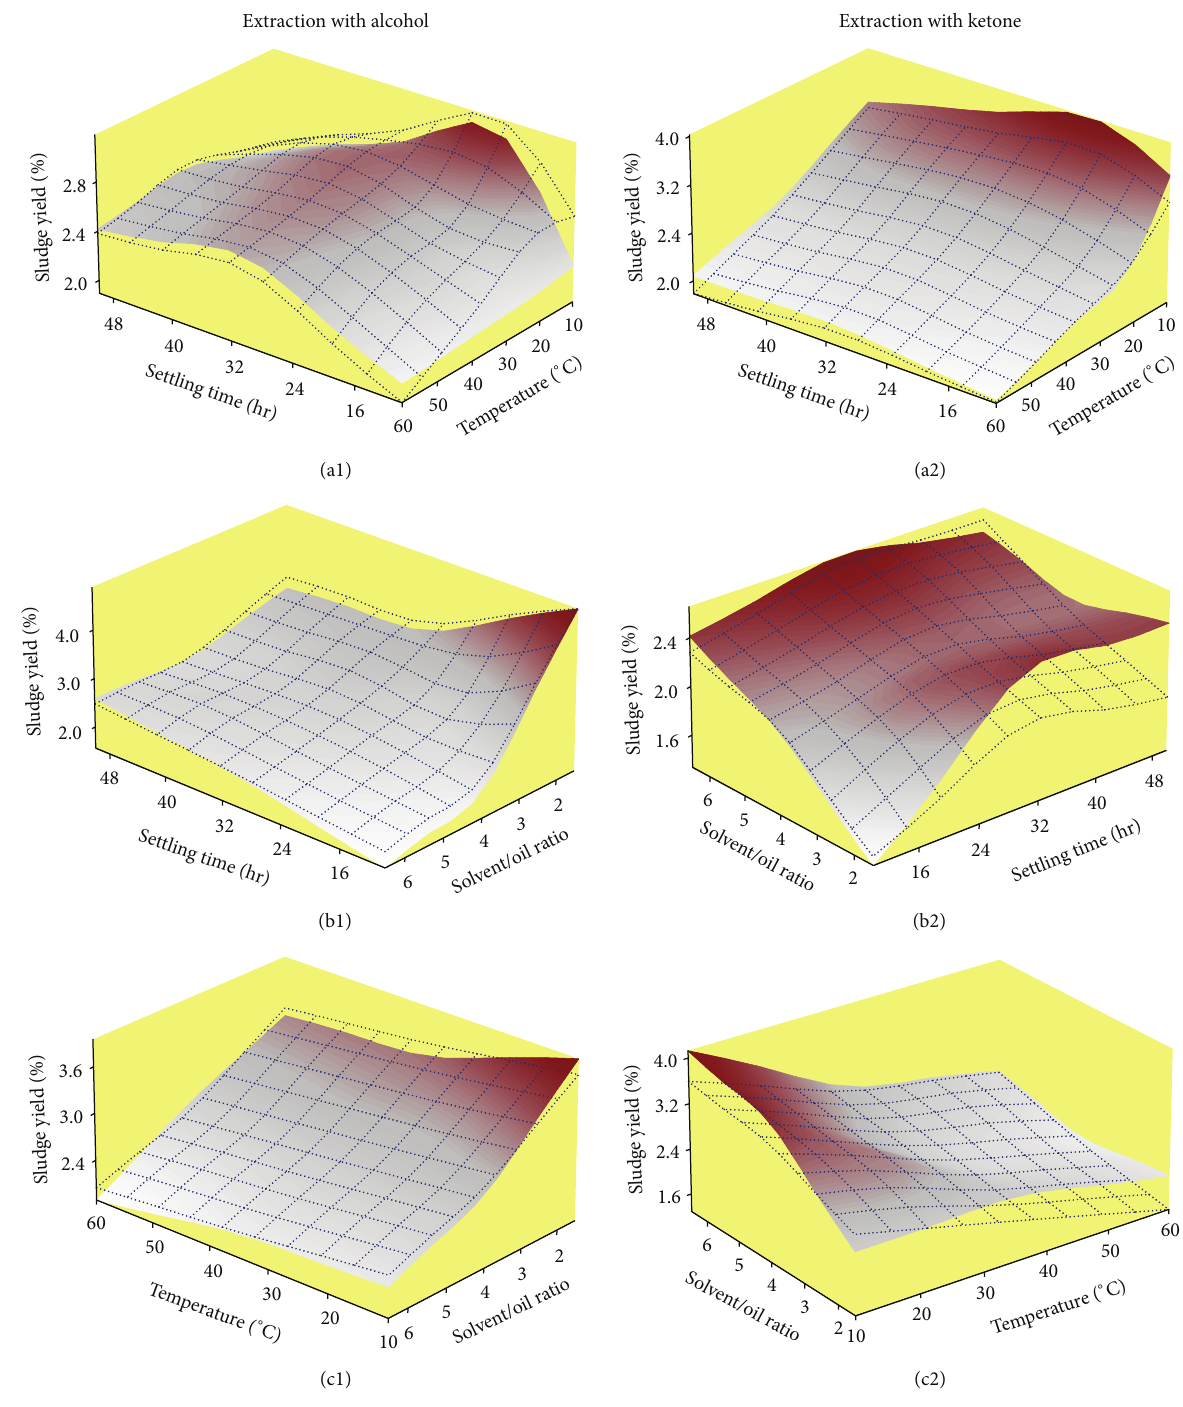
Figure 5: (a) Comparison of response surfaces describing simultaneous variation of sludge yield against 𝑡 and 𝑇 . (b) Against 𝑡 and 𝑟 . (c) Against 𝑇 and 𝑟 . Color maps are actual response surfaces while superimposed dotted mesh are the response surfaces, predicted by the multivariate process models (7) or